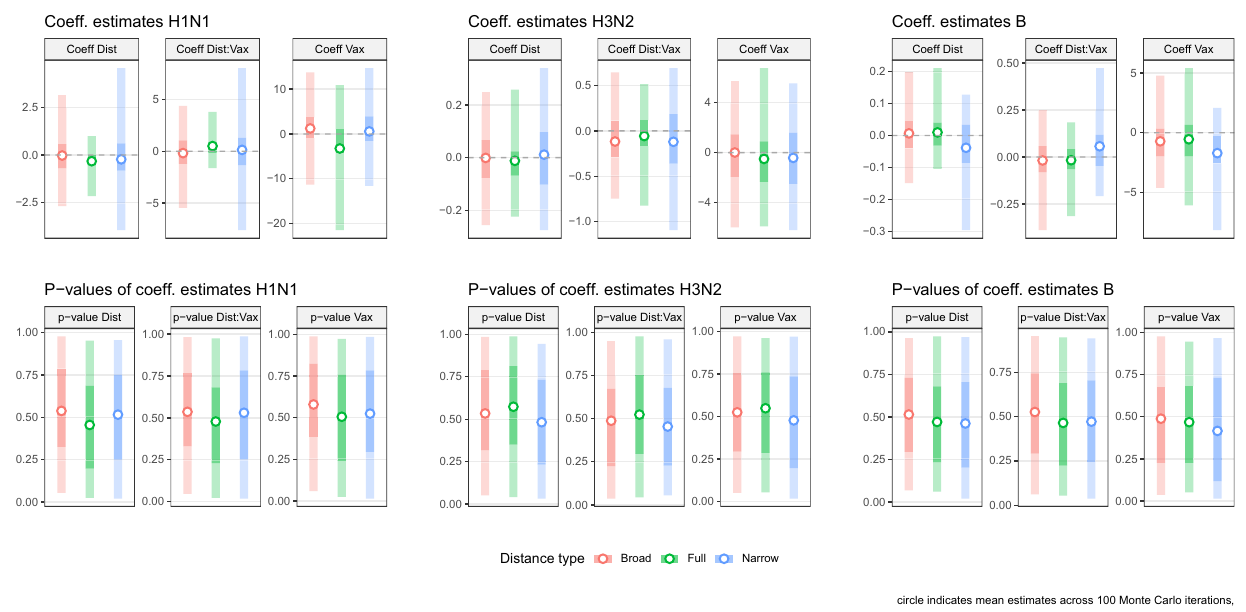
Figure 3. Regression results. The top panels represent the estimated values of the regression coefficients and the bottom panels their corresponding p -values. In all panels, the circle represents the mean estimate, the light and dark vertical bars 95% and 50% quantiles across 100 Monte Carlo iterations. “Dist” represents the covariate for the mean inter-season antigenic distance; “Vax” the covariate for the vaccine effectiveness; “Dist:Vax” the interaction